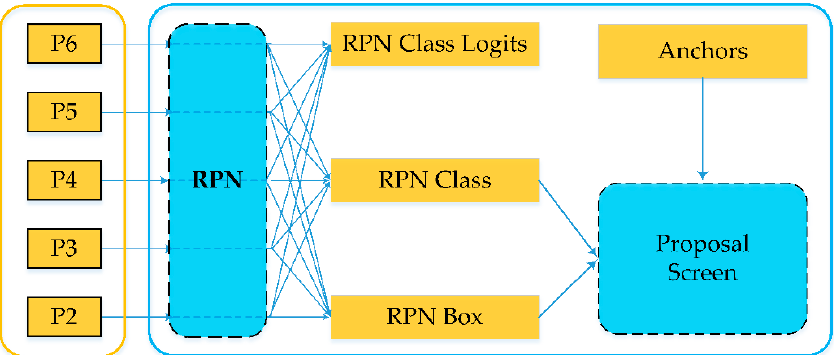
Figure 9. Overall flow chart of regional proposal network (RPN).